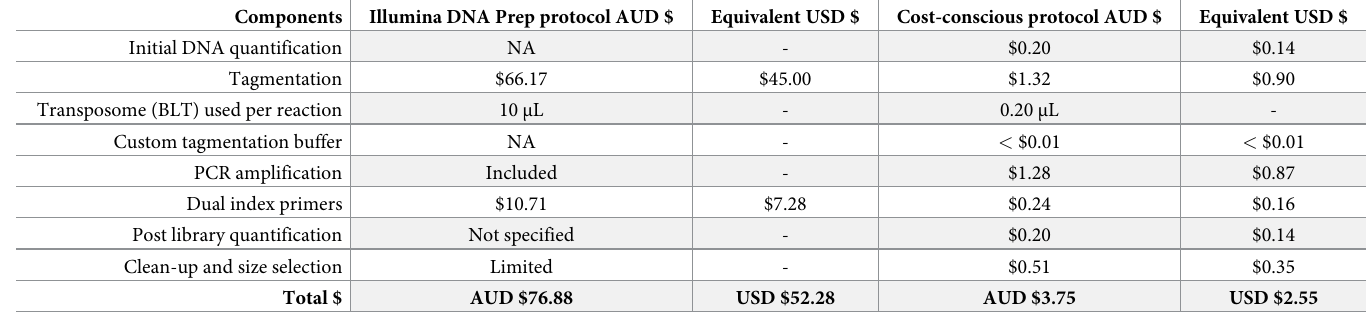
Table 1. Price comparison between the Illumina DNA Prep protocol and our presented cost-conscious protocol, per sample reaction when performed in high- throughput (96-well microplates). The key difference, the volume of bead-linked transposome (BLT) is also presented. Prices calculated from Australian retail prices (as of July 2022) and presented in the Australian dollar (AUD) and the United States Dollar equivalent (USD to AUD rate of 1.47 as of July 2022). Standard laboratory con- sumables (such as 96-well microplates, filter tips and microfuge tubes) were excluded, being considered equal in expenditure between the two protocols. Further pricing details are provided in the supplementary